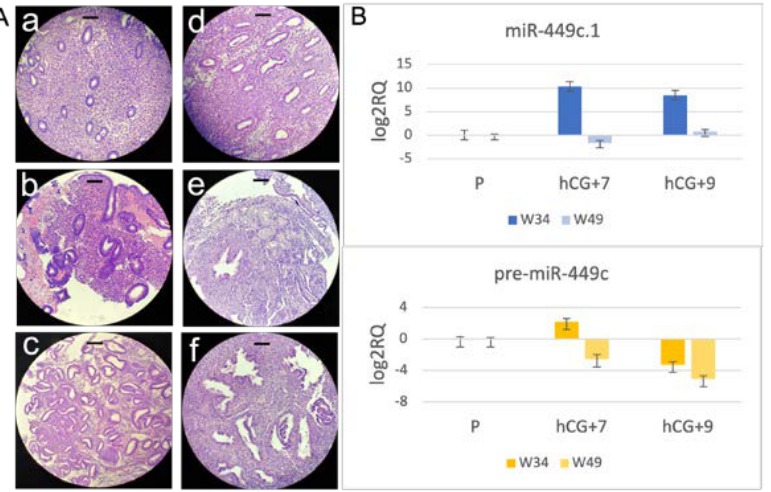
Figure 3. Correlation of miR-449c.1 and pre-miR449c expression with endometrial histological pattern in a case study. ( A ) Endometrial histological pattern of a 34-year-old woman (W34, a–c) and a 49-year-old woman (W49, d–f) at proliferative phase (a,d), hCG + 7 (b,e) and hCG + 9 (c,f), scale bars 50 μm. ( B ) Relative expression levels of miR-449c.1 (blue) and pre-miR449c (yellow) in W34 and W49 analyzed using SL RT-qPCR—hCG + 7 and hCG + 9 compared with the proliferative phase (P) of the corresponding woman. Error bars represent standard deviation of three technical repeats.